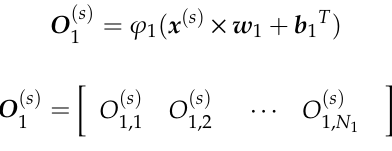
Figure 3. Structure of the multilayer perceptron (MLP) model.